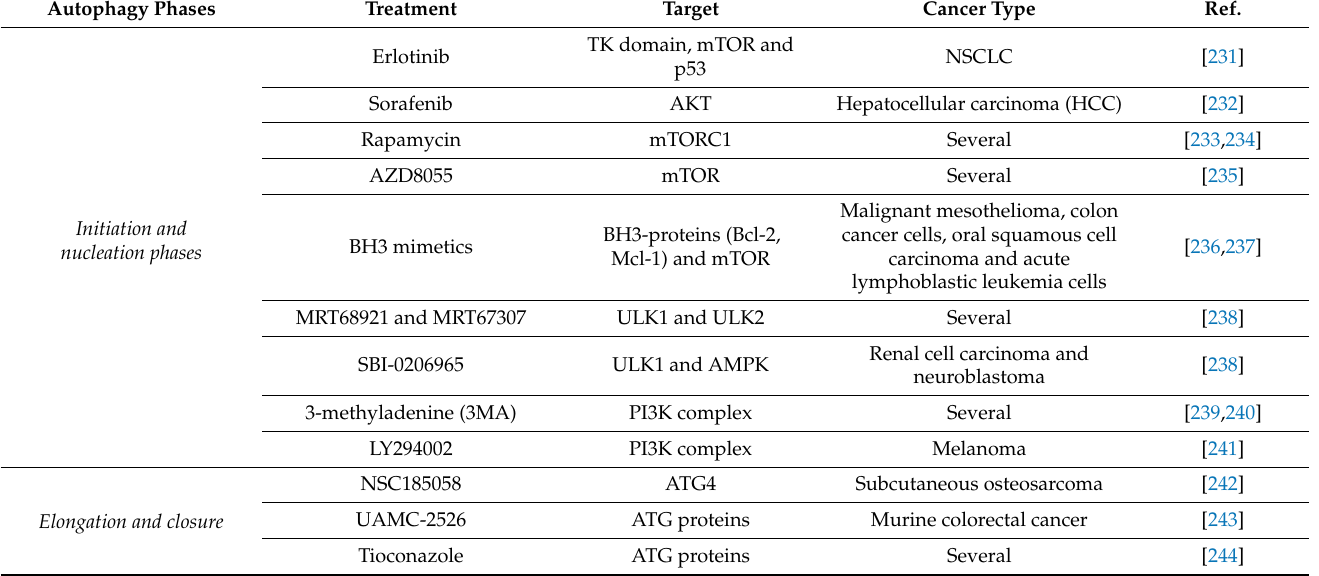
Table 1. Targeting autophagy as a promising strategy for cancer